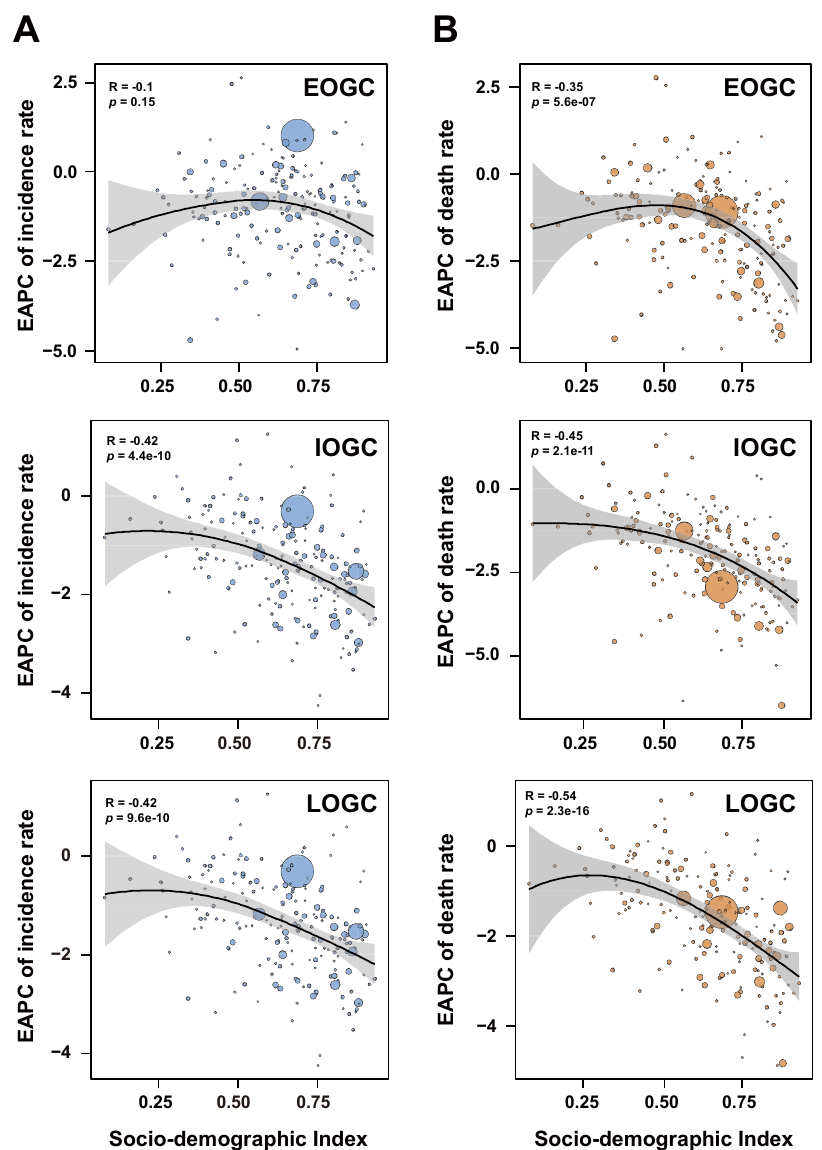
Figure 3. Correlations between estimated annual percentage changes in gastric cancer and SDI values. ( A ) Correlations between estimated annual percentage changes of incidence rates in gastric cancer and SDI values; ( B ) Correlations between estimated annual percentage changes of death rates in gastric cancer and SDI